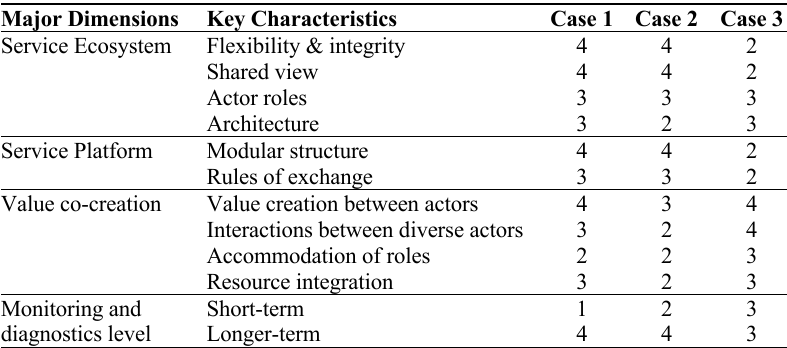
Table 5. Cross-case analysis of the three